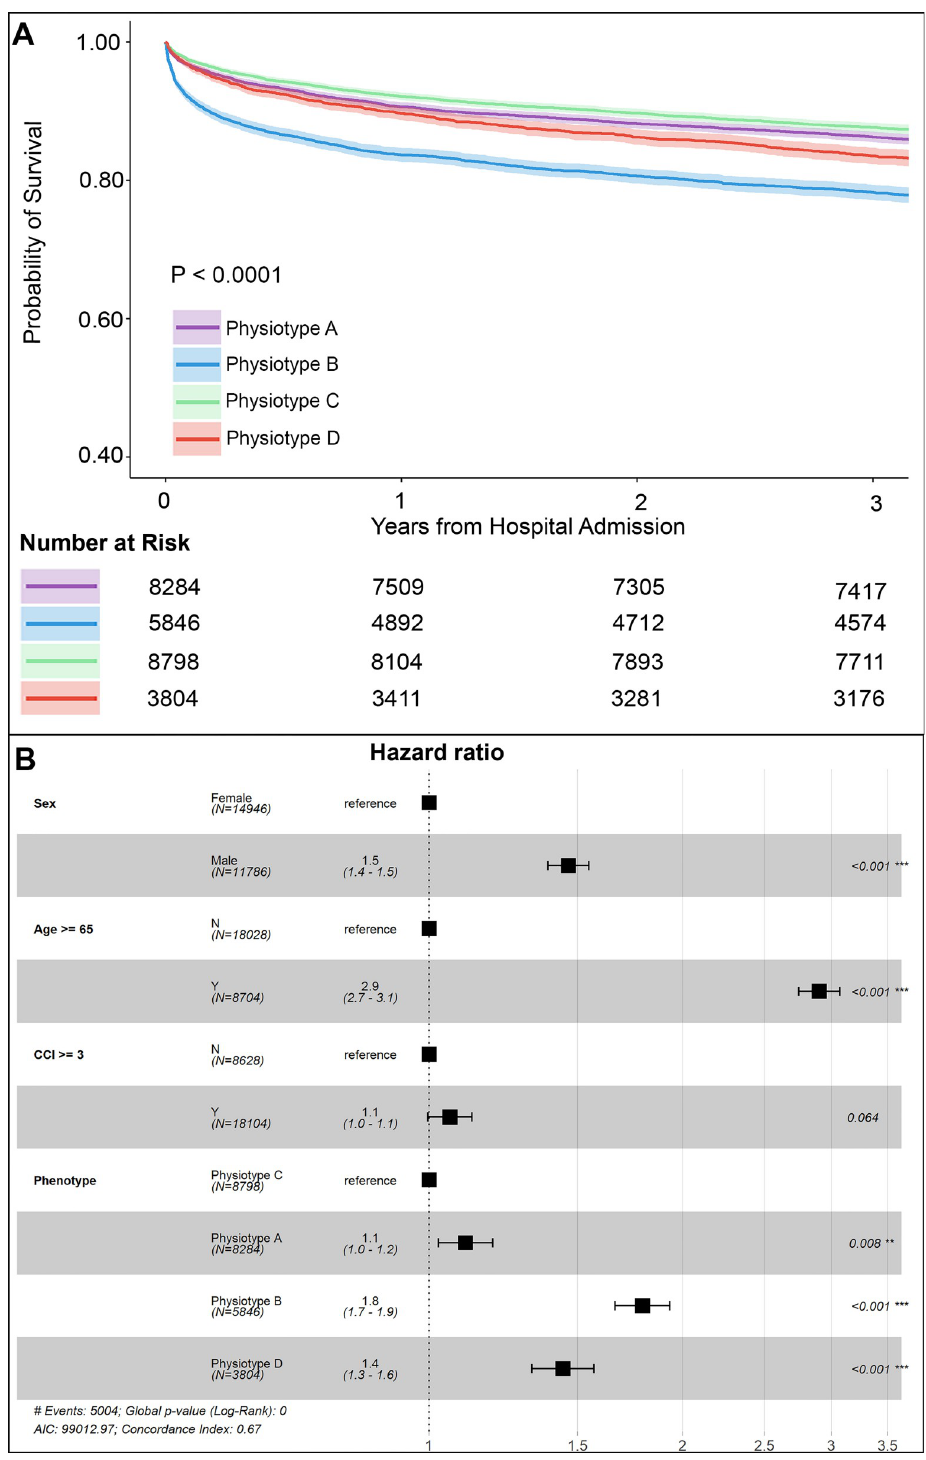
Fig 3. Survival curves and Cox proportional hazards modeling. (A) Physiotype survival curves adjusted using demographic information and comorbidities. (B) Adjusted Cox proportional hazards models using demographic information and comorbidities. CCI: Charlson Comorbidity